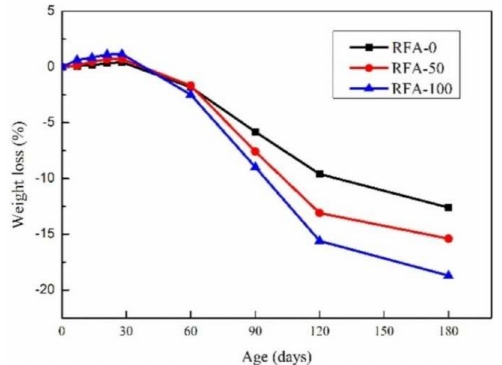
Figure 7. Weight loss of alkali − activated slag concrete